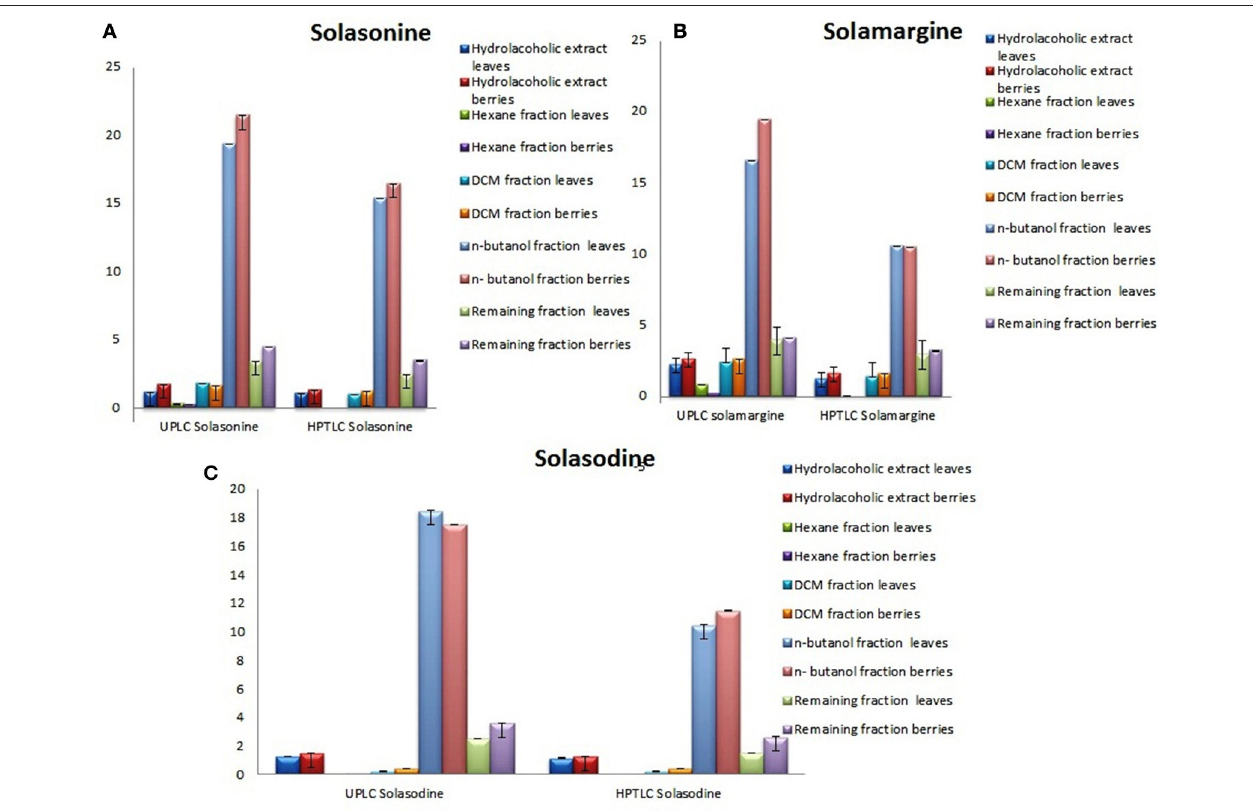
FIGURE 4 | Graphical designing to show the content of (A) Solasonine, (B) Solamargine, and (C) Solasodine present in S. nigrum (areil part) mother extract and its fractions by UPLC-ESI-MS/MS and HPTLC